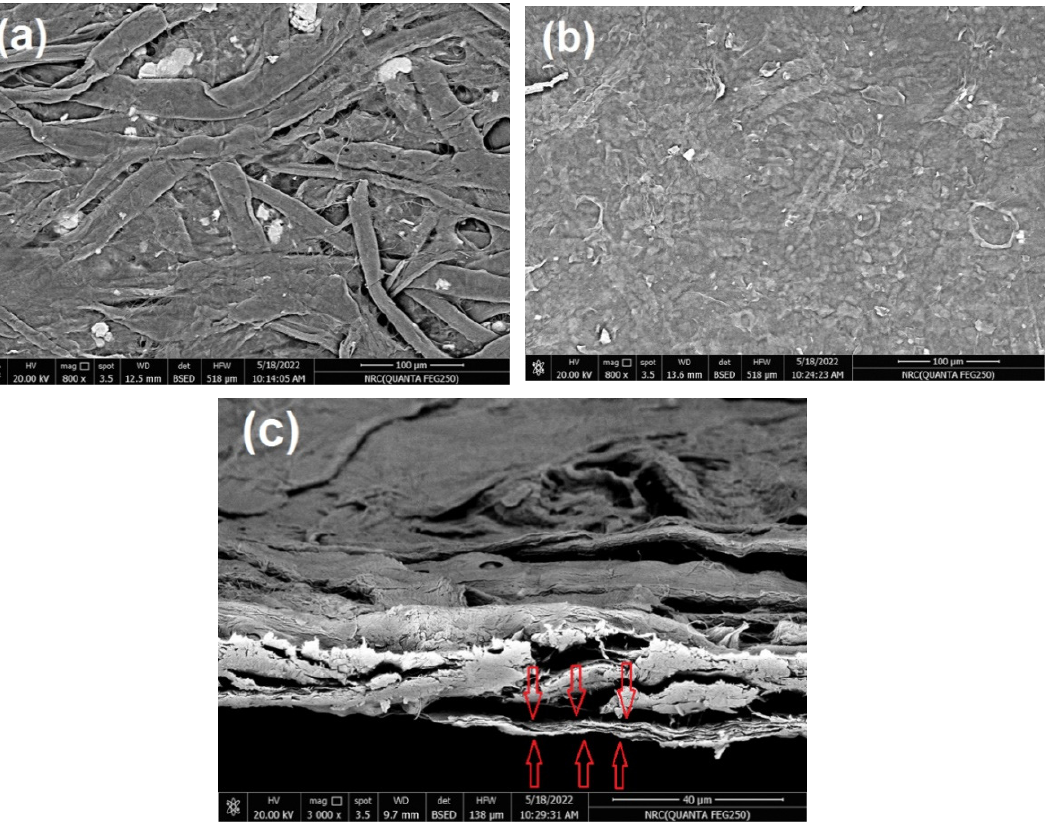
Figure 7. Scanning electron microscopy (SEM) of ( a ) the surface of a paper sheet before coating, ( b ) the surface of a paper sheet after coating with CNFs/20% Pectin/PGE, and ( c ) the cross-section of a paper sheet after coating with CNFs/20% Pectin/PGE.